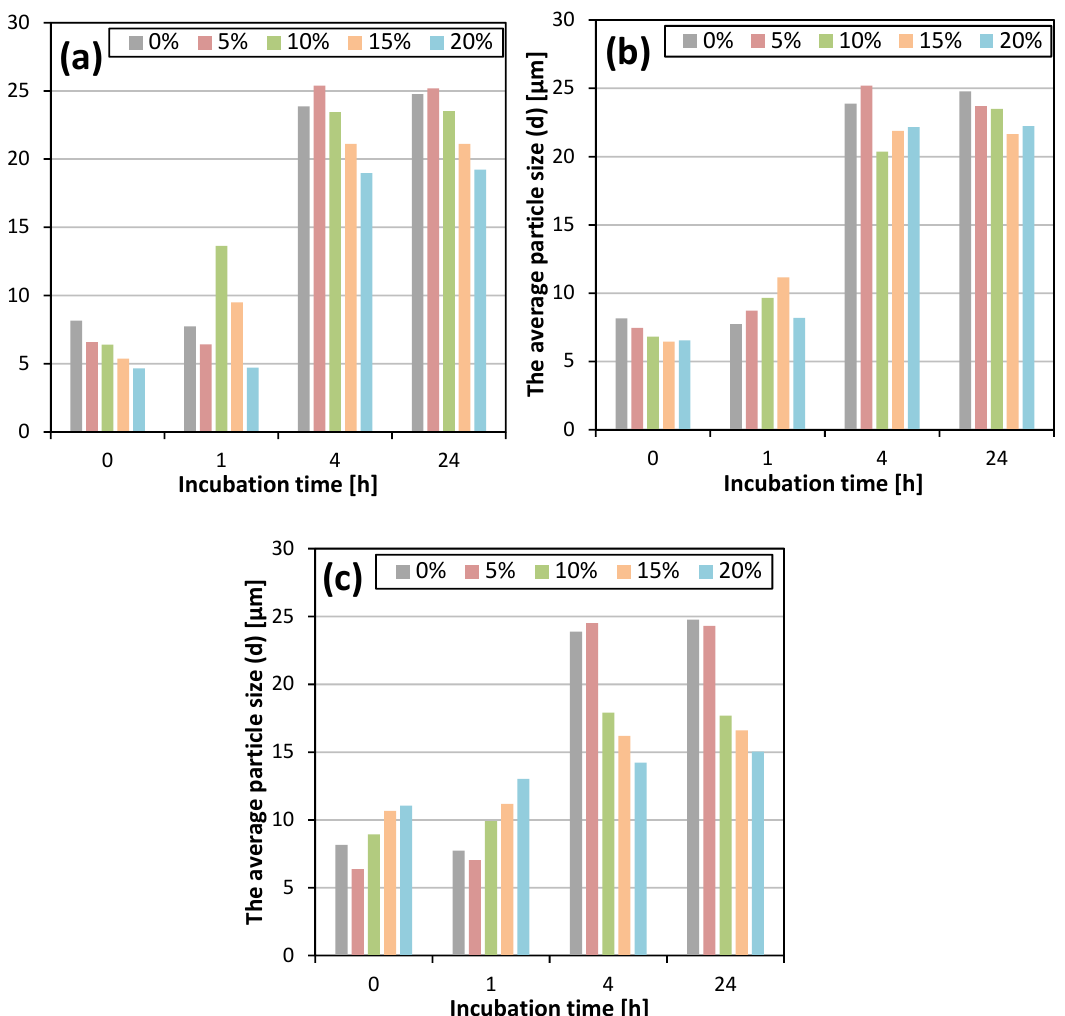
Figure 3. The average particle size (d) depending on the incubation time and solvent concentration for DMSO ( a ), methanol ( b ) and isopropanol ( c ).